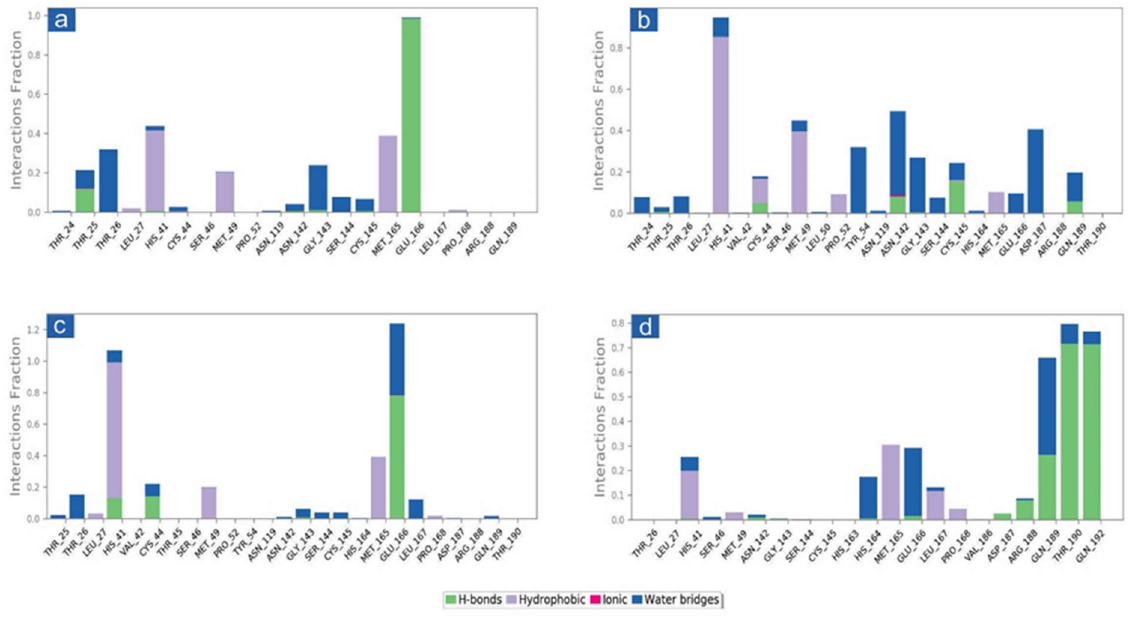
Figure 4 . Protein-ligand interactions mapping for SARS-CoV-2 docked with potential compounds, i.e., ( a ) Cassameridine, ( b ) Laetanine, ( c ) Litseferine, and ( d ) Cassythicine, extracted from 100 ns MD simulations. Herein, values of interaction fractions >1.0 are feasible as some residues established several interactions of the similar subtype.